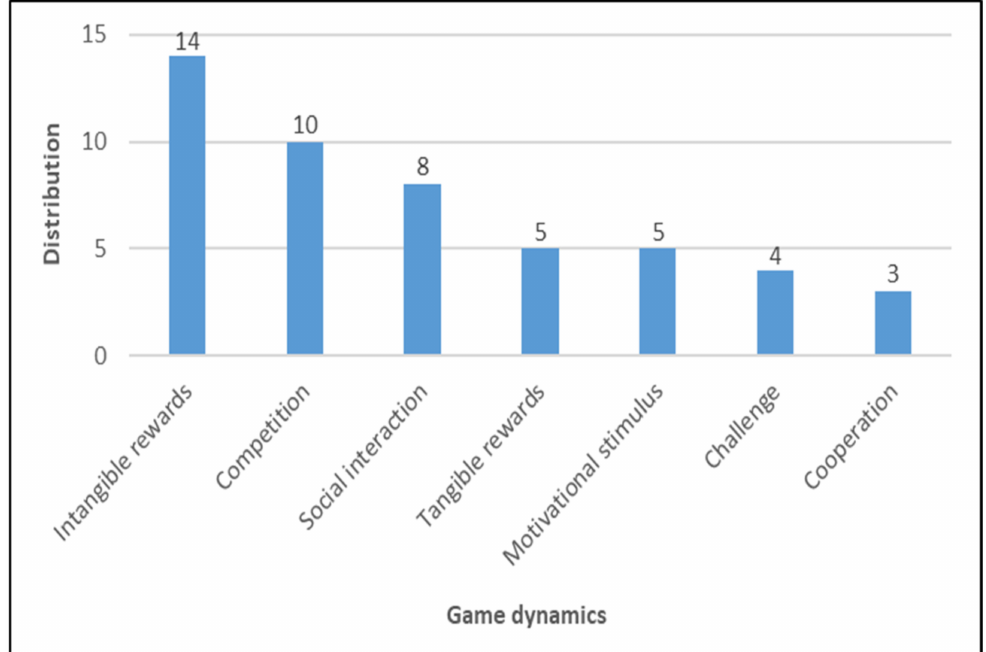
Figure 4. Distribution of game dynamics across “crowdsourcing” case